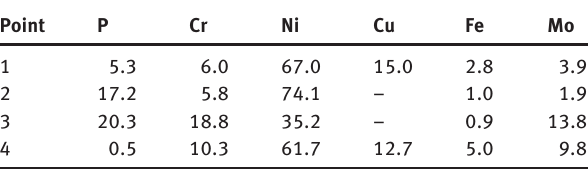
Table 1: Chemical compositions of the points (mass%) Point